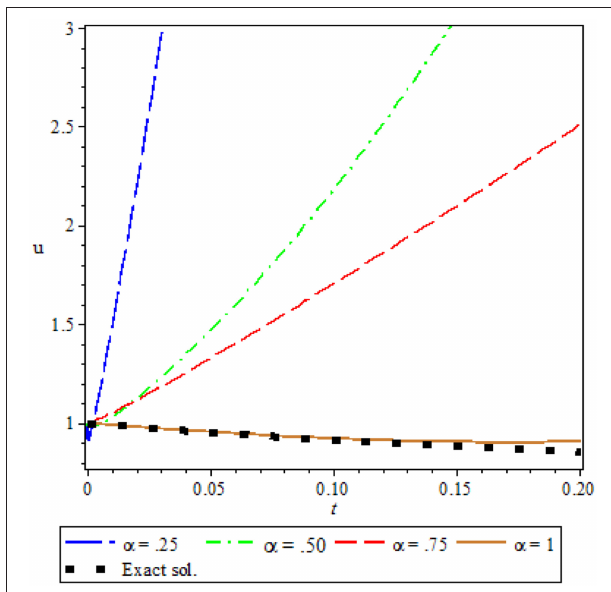
FIGURE 3 | Comparison of approx. sol. for different values of α and exact sol. at α 1, for Ex. =